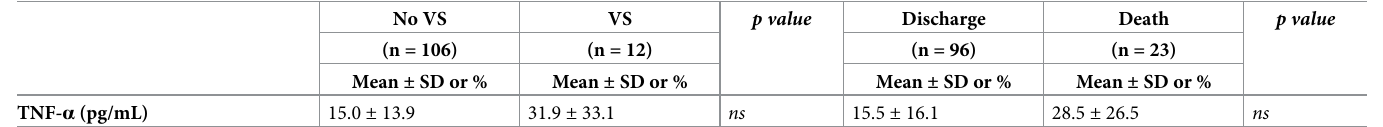
Abbreviations: ALT, alanine aminotransferase ; AST, aspartate aminotransferase ; BUN, blood urea nitrogen ; CK, creatin kinase ; Hb, hemoglobin ; hsCRP, high sensitivity C-reactive protein ; HbA1c, glycated hemoglobin ; IL-6, interleukine-6 ; LDH, lactate dehydrogenase ; MCV, mean corpuscolar volume ; ns, not significant ; NT-proBNP, N- terminal fragment of the prohormone brain-type natriuretic peptide ; RBCs, red blood cells ; SD, standard deviation ; TNF- α , tumor necrosis factor- α ; VS, ventilation support; WBCs, white blood cells .